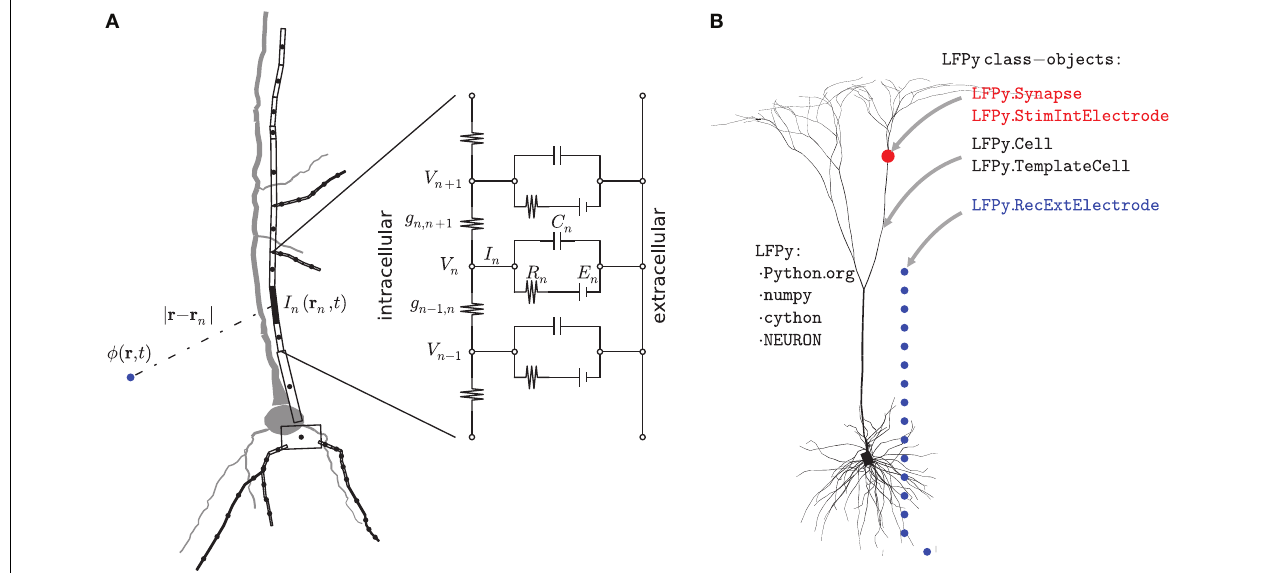
compartment n , is then used in the forward-modeling schemes in Equations (3–5) to calculate extracellular potentials. (B) LFPy is a Python package, dependent on numpy , Cython and NEURON, implementing this combined modeling scheme. Its main features are object-oriented representations of biophysically detailed neurons ( LFPy.Cell, LFPy.TemplateCell ), point-process mechanisms